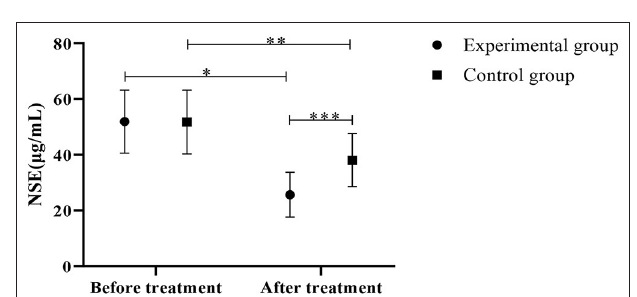
FIGURE 5 | Comparison of NSE levels between the control group and the experimental group (Mean, SD). The abscissa indicates before and after the treatment, and the ordinate indicates the NSE level, µ g/mL; The NSE levels of patients in the experimental group before and after the treatment were (51.88 ± 11.33) µ g/mL and (25.65 ± 8.02) µ g/mL respectively; The NSE levels of patients in the control group before and after the treatment were (51.75 ± 11.45) µ g/mL and (38.02 ± 9.52) µ g/mL respectively; * Indicates that there is a significant difference in the NSE level of the experimental group before and after the treatment ( t = 9.448, P < 0.001); ** Indicates that there is a significant difference in NSE level before and after the treatment in the control group ( t = 4.610, P < 0.001); *** Indicates that there is a significant difference in the NSE levels of the two groups of patients after the treatment ( t = 4.969, P <